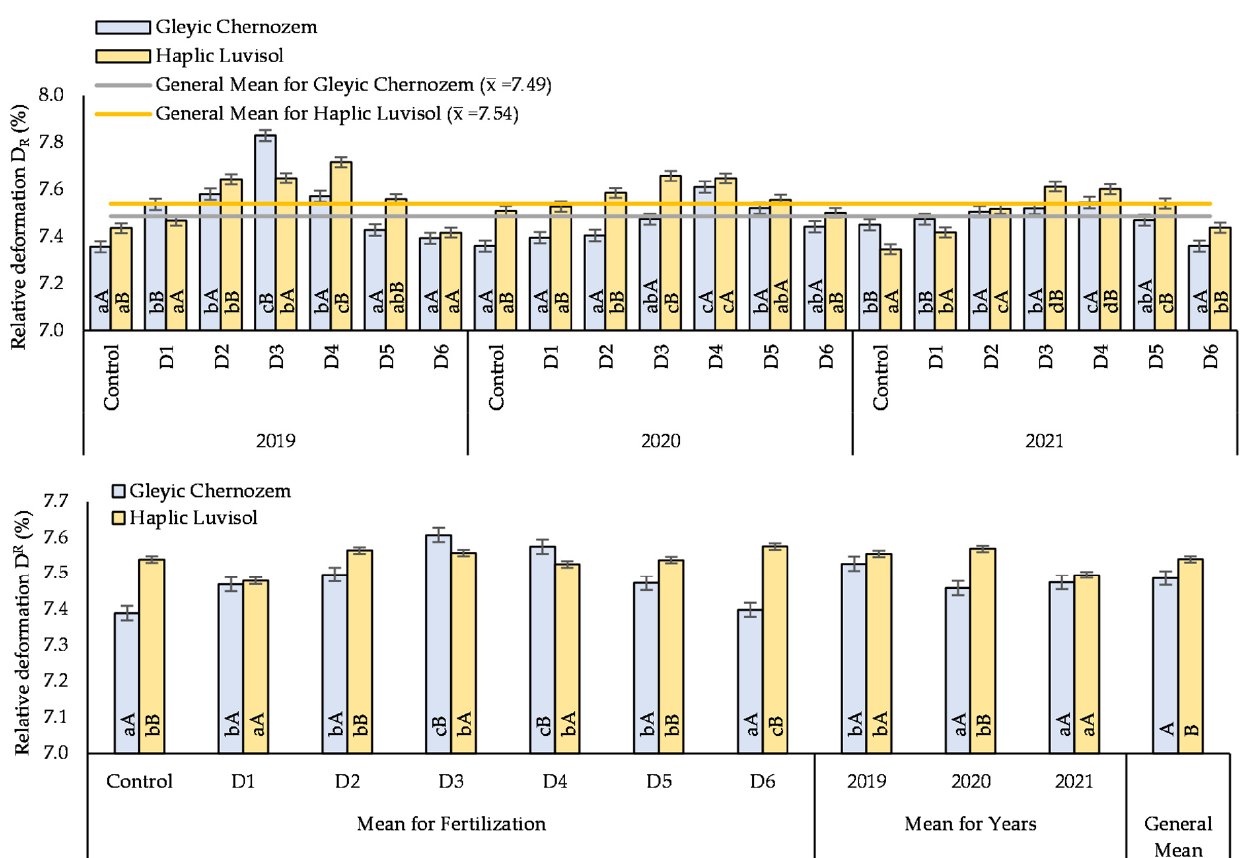
Figure 5. Average values of the relative deformation DR (%) depending on the type of soil, fertiliser applied and year of research. Statistical data are expressed as mean ±SD values. Different letters show significant differences ( p < 0.05) according to Tukey’s range test. Capital letters mean differences between particular types of soil, small letters mean differences between particular doses of fertiliser.